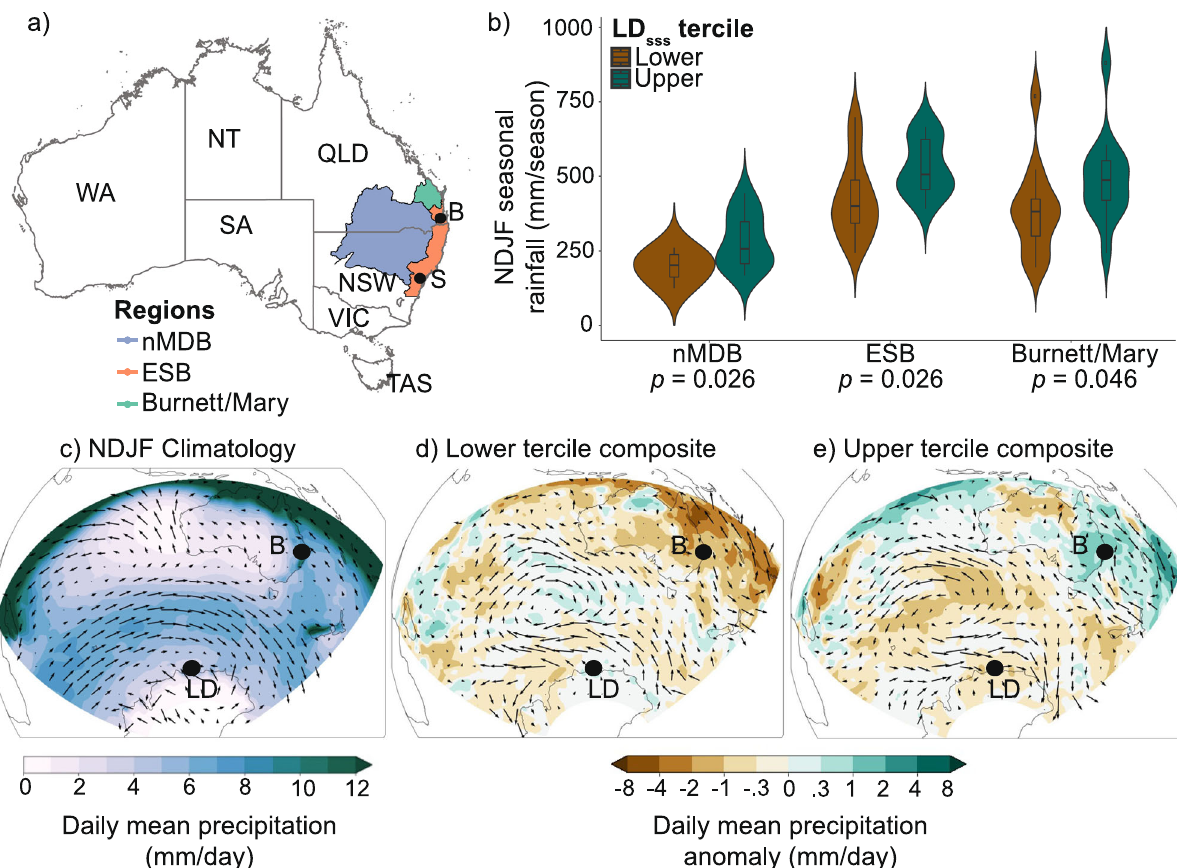
Fig. 1 Seasonal relationship between Law Dome summer sea salt (LD sss ) and eastern Australia rainfall over NDJF period from 1979/80 to 2015/16. a Australia map including locations of major east coast cities of Brisbane (B) and Sydney (S) and rainfall regions most strongly correlated to LD sss 17,25 , incorporating key agricultural and urban water supply catchments; nMDB (blue) = northern Murray Darling Basin, ESB (orange) = eastern seaboard, and Burnett/Mary River catchment (green). b NDJF seasonal regional rainfall distributions over 1979/80 to 2015/16 for LD sss upper (LD sss > 0.192 logCl, n = 13) and lower (LD n = 12) tercile years (>66%, <33%). Wilcoxon signed-rank test used to determine the signi fi cance (95%) of mean sss < 0.014 logCl, regional rainfall between LD sss upper/lower tercile years over 1979/80 – 2015/16. Refer to Supplementary Fig. S1a for LD sss timeseries split by tercile groups. c NDJF climatology over 1979/80 – 2015/16 (ERA-Interim 58 ) of daily total precipitation and surface winds (10 m) over study domain, including location of Brisbane (B) and Law Dome (LD). d NDJF composite conditions of daily total precipitation and surface wind (10 m) anomalies during LD sss lower tercile years. e As e during LD sss upper tercile